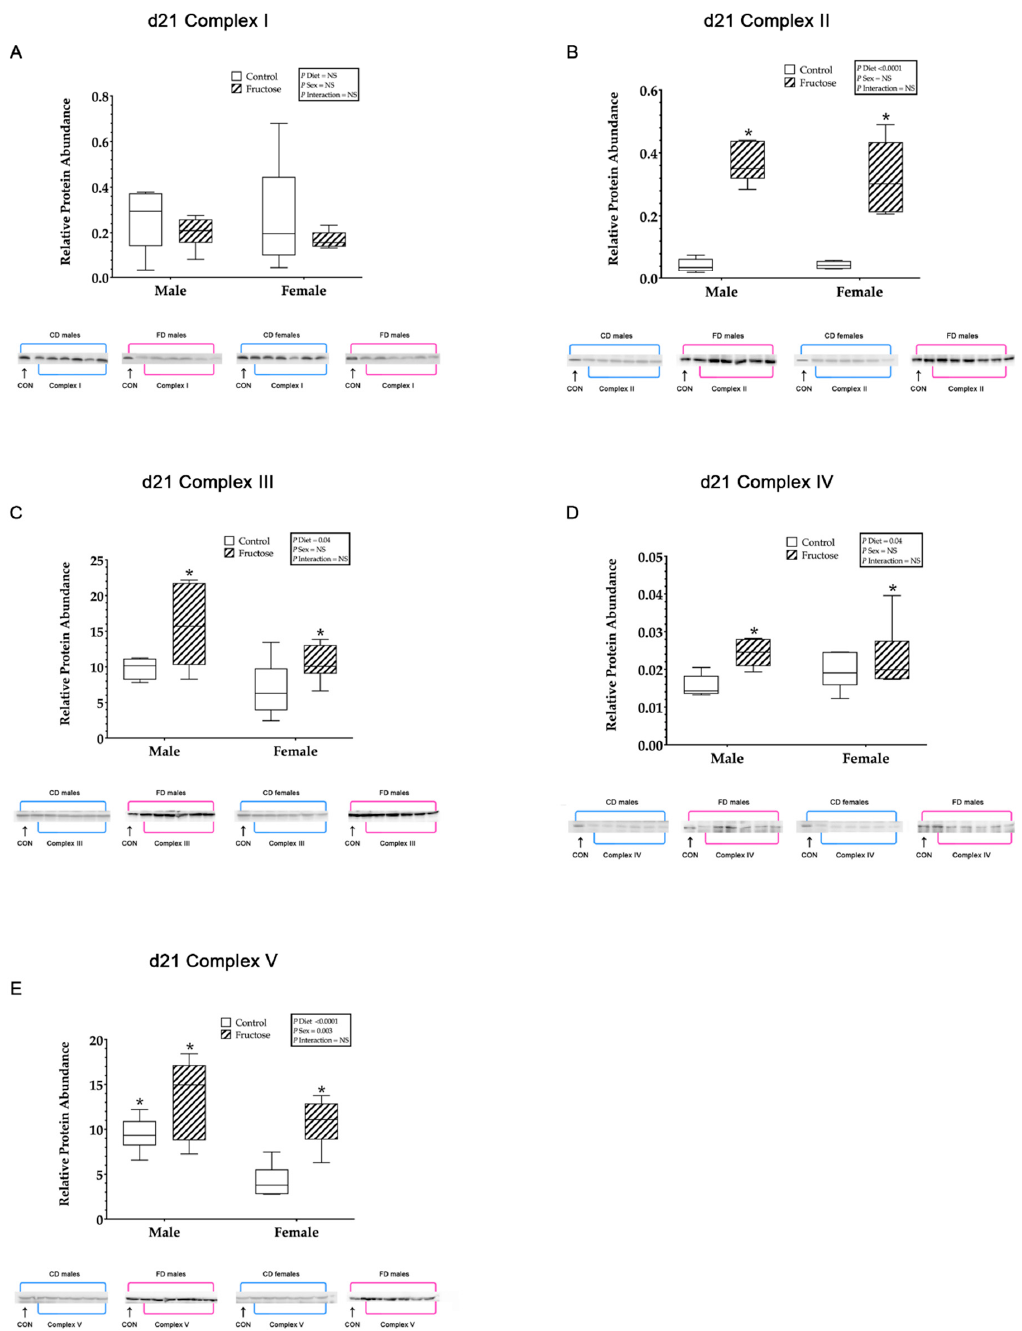
Figure 3. ( A – D ) Weanling and adult offspring hepatic mitochondrial electron transport and oxidative phosphorylation complexes I, II, III, IV and ATP synthase. Weanling offspring control males ( n = 6); fructose males ( n = 6); control females ( n = 6) and fructose females ( n = 6). ( A ) Represents weanling offspring hepatic mitochondrial complex-I relative protein abundance and Western blot image at D21. ( B ) Represents weanling offspring hepatic mitochondrial complex-II relative protein abundance and Western blot image at D21. ( C ) Represents weanling offspring hepatic mitochondrial complex-III relative protein abundance and Western blot image at D21. ( D ) Represents weanling offspring hepatic mitochondrial complex-IV relative protein abundance and Western blot image at